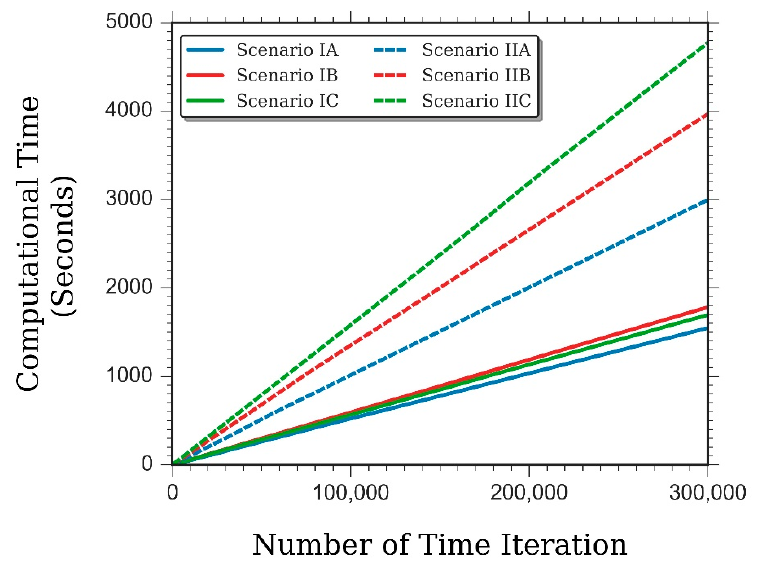
Figure 5. Computational overhead of disparate LBM schemes in modelling natural convection in a differentially-heated cavity with Ra = 10 4 , Pr = 0.71, τ υ = 0.6 and Ma = 0.1, starting from the unsteady period up to the accomplishment of the steady-state period.